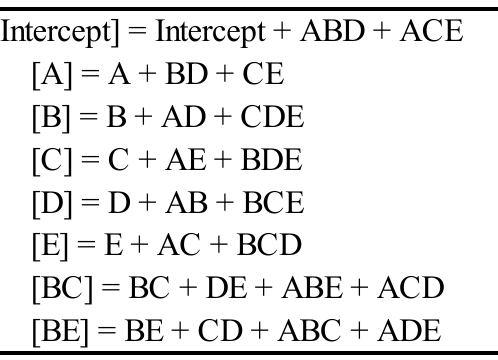
Figure 1. Efficient Array EA (20, 2 4 3 1 4 1 ).